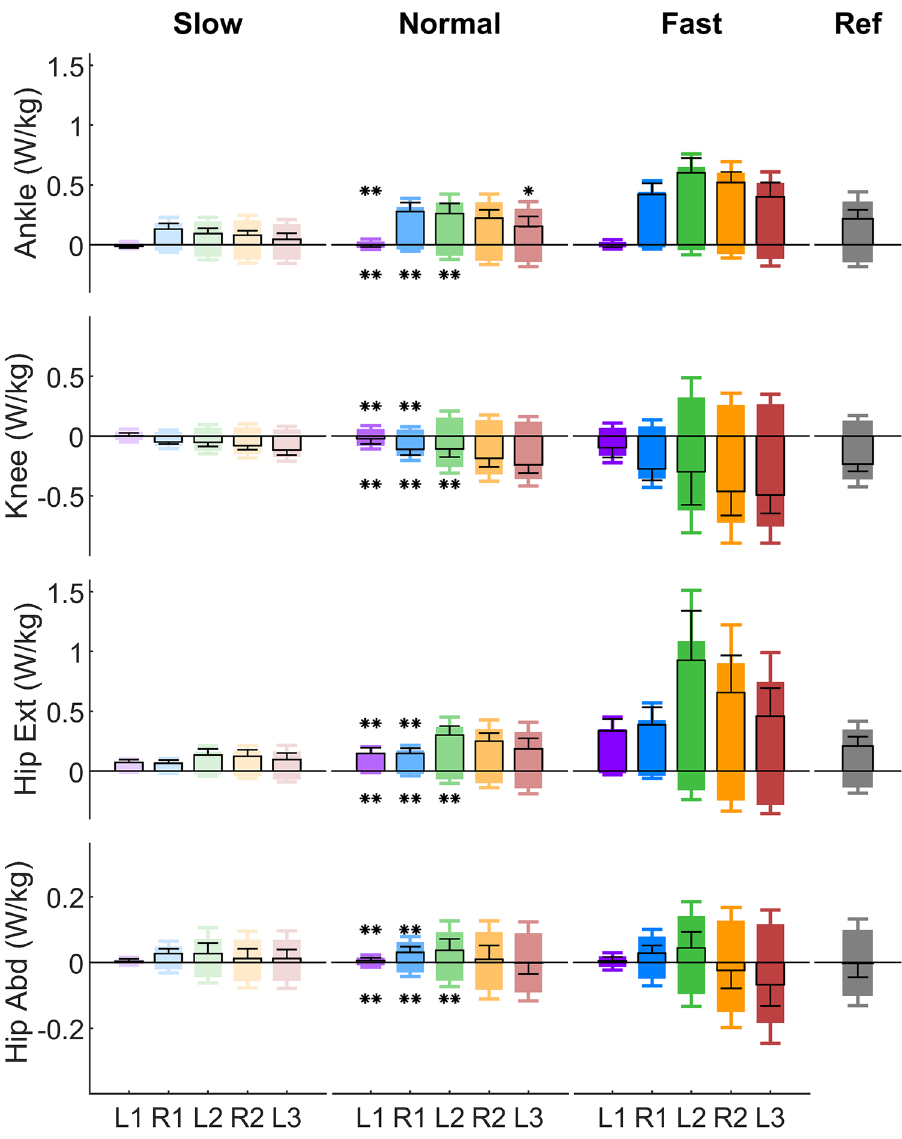
Figure 5. Average positive, negative and net joint power for the first five strides (L1, R1, L2, R2, L3) of slow, normal and fast target velocity gait initiation and for the reference walking (Ref). Error bars indicate ± 1 standard deviation. Positive bars indicate positive power. Negative bars indicate negative power. Black frames indicate average net joint power. The single asterisk (*) and double asterisks (**) indicate a significant difference at p < 0.05 and p < 0.01 with respect to Ref, respectively. Detailed statistical analysis results can be found in Supplementary Table